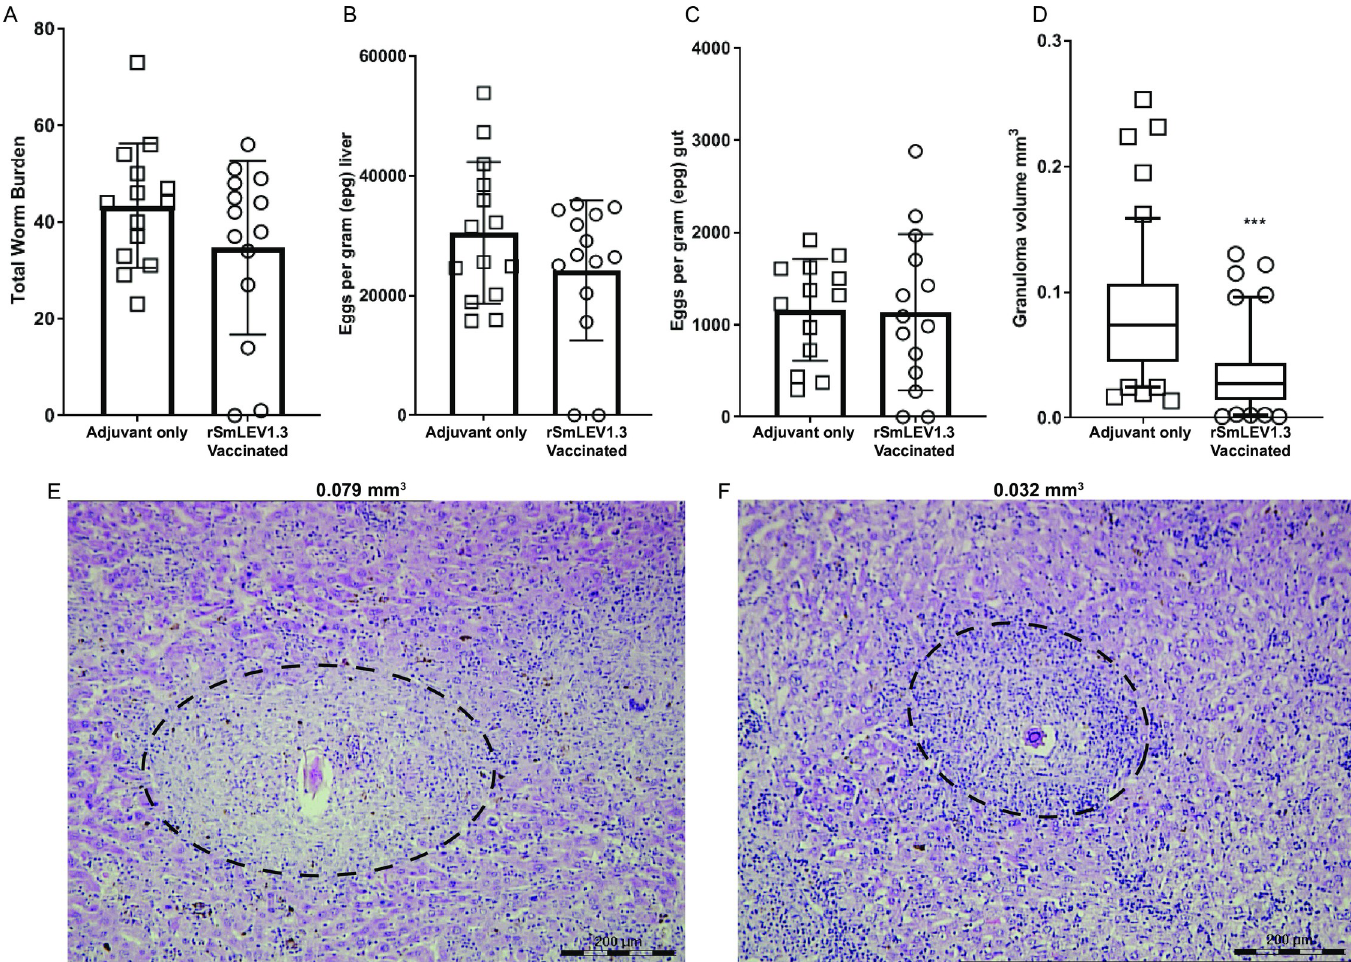
Fig 7. rSmLEV1.3 vaccination led to a non-significant reduction in adult worm and egg burdens, but a significant reduction in egg-induced liver granuloma volumes. (A) Upon termination of the vaccine regime (7 weeks post cercarial challenge) the mean number of adult worms was 17% lower in vaccinated (n = 14) animals compared to control animals (n = 14). (B) In addition, rSmLEV1 vaccination led to a 21% reduction in the number of liver-resident eggs. (C) The number of gut-resident eggs was similar between treatment groups. (D) rSmLEV1.3 vaccinated mice showed a greater than 60% reduction in liver granuloma volumes (p < 0.001, ��� ). The boxplot shows the median (line) with the upper and lower quartile (box) as well as the 5–95 percentile (whiskers). Each data point is the average granuloma volume per mouse, from 10 individual granulomas. Histological sections of liver were taken from control (E) and vaccinated (F) mice and stained with H&E. Granulomas with volumes closest to the mean for each treatment group were chosen for